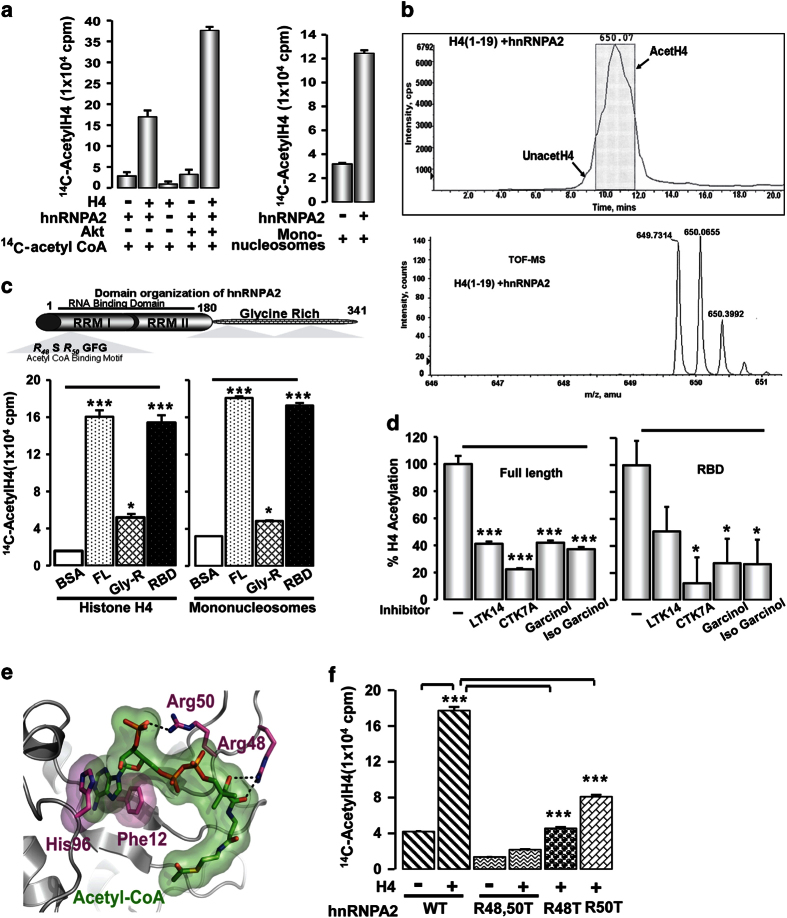
Characterization of KAT activity of hnRNPA2. (a) (Left panel) KAT activity of
purified ×6 His-HnRNPA2 measured by a filter-binding assay using H4 peptide
(residues 1–19) and 14C Acetyl-CoA as substrates (Supplementary Figure S2). Recombinant Akt kinase (Millipore, Cat #
14–276) was used to phosphorylate hnRNPA2 before the filter-binding assay as
indicated (Supplementary Figure S2I). (Right panel)
Filter-binding assay showing acetylation using mononucleosomes as substrate. (b)
(Top) Liquid chromatography–mass spectrometry (LC-MS) profile of
hnRNPA2-mediated acetylation status using histone H4 (synthetic H4 1–19
residues). (Bottom) Chromatogram showing the total ion counts of acetylated H4 (residues
1–19) peptide after reaction with hnRNPA2. The X-axis represents the
liquid chromatography running time and the Y-axis represents the ion counts.
(Bottom panel) The peak in the top panel was highlighted to generate the TOF-MS bottom
panel. (c) (Top) Domain architecture of hnRNPA2. (Bottom) KAT activity of ×6
His-HnRNPA2 (full-length), RNA binding domain (RBD) (residues 1–180) and
glycine-rich domain (residues 180–341) assessed by filter-binding assay using
14C acetyl-CoA and H4 peptide (residues 1–19) as substrates.
(d) Inhibition of H4 acetylation by hnRNPA2 (full-length and RBD) using
14C acetyl-CoA in the presence of 100 μm synthetic
KAT inhibitors (as indicated). (e) Proposed model for acetyl-CoA binding by
hnRNPA2. A homology model of hnRNPA2 based on the hnRNPA1 structure (gray) with
acetyl-CoA docked (green; see ‘Materials and Methods’ section) suggests
that the adenosine base is sandwiched between two aromatic residues (H96 and F12;
magenta), whereas additional interactions are established with Arg 48 and Arg 50
(magenta). (f) KAT activity of the purified full-length hnRNPA2 WT and R48T and
R50T mutants using 14C Acetyl-CoA and H4 peptide (residues 1–19) as
substrates. For LTK14, garcinol and isogarcinol DMSO alone was used in control assays
run alongside.